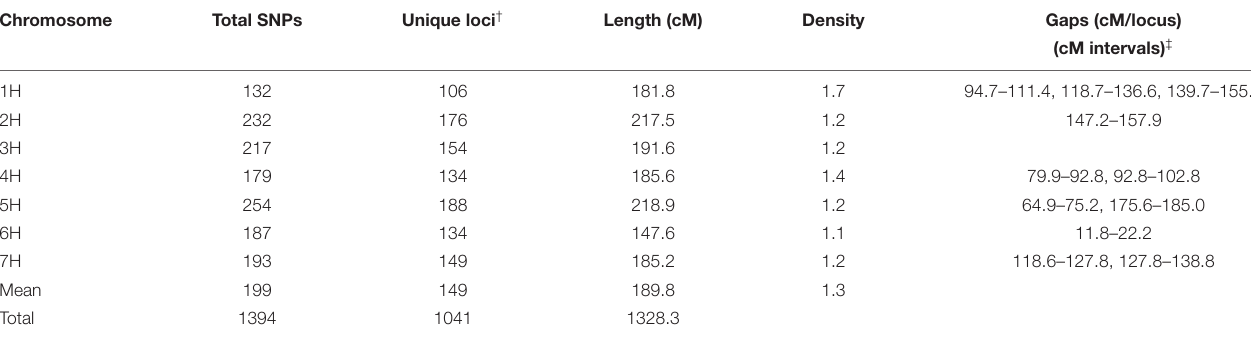
TABLE 3 | Distribution and density of SNP markers in the Rasmusson × PI383933 recombinant inbred line (RIL) population. Chromosome Total SNPs Unique loci † Length (cM) Density Gaps